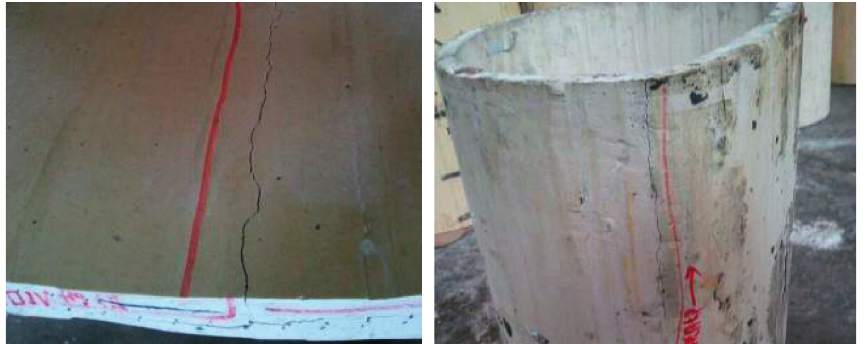
Figure 8: Lining cracks of reinforced concrete.